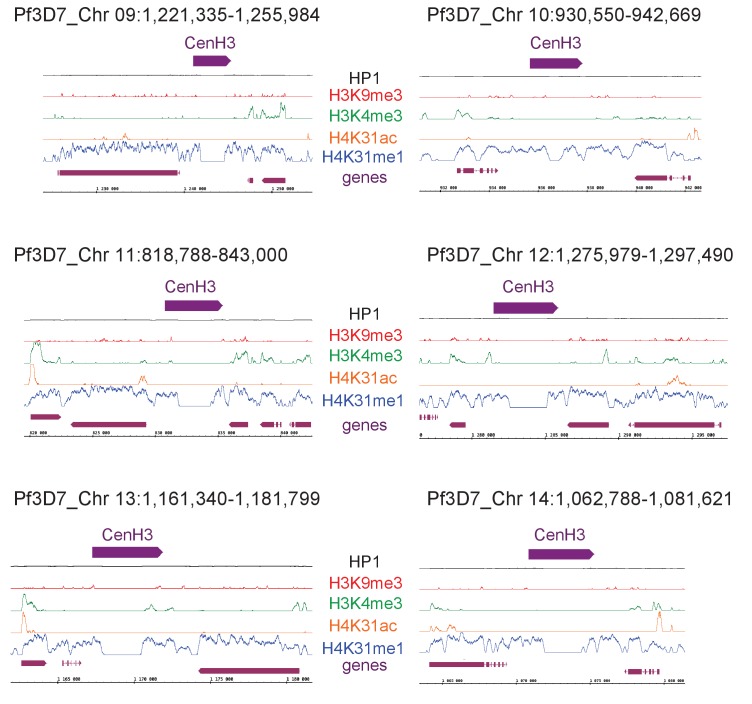
H4K31me1 marks pericentromeric chromatin in P. falciparum.Zoomed-in views of centromeric and peri-centromeric chromatin from P. falciparum chromosomes.